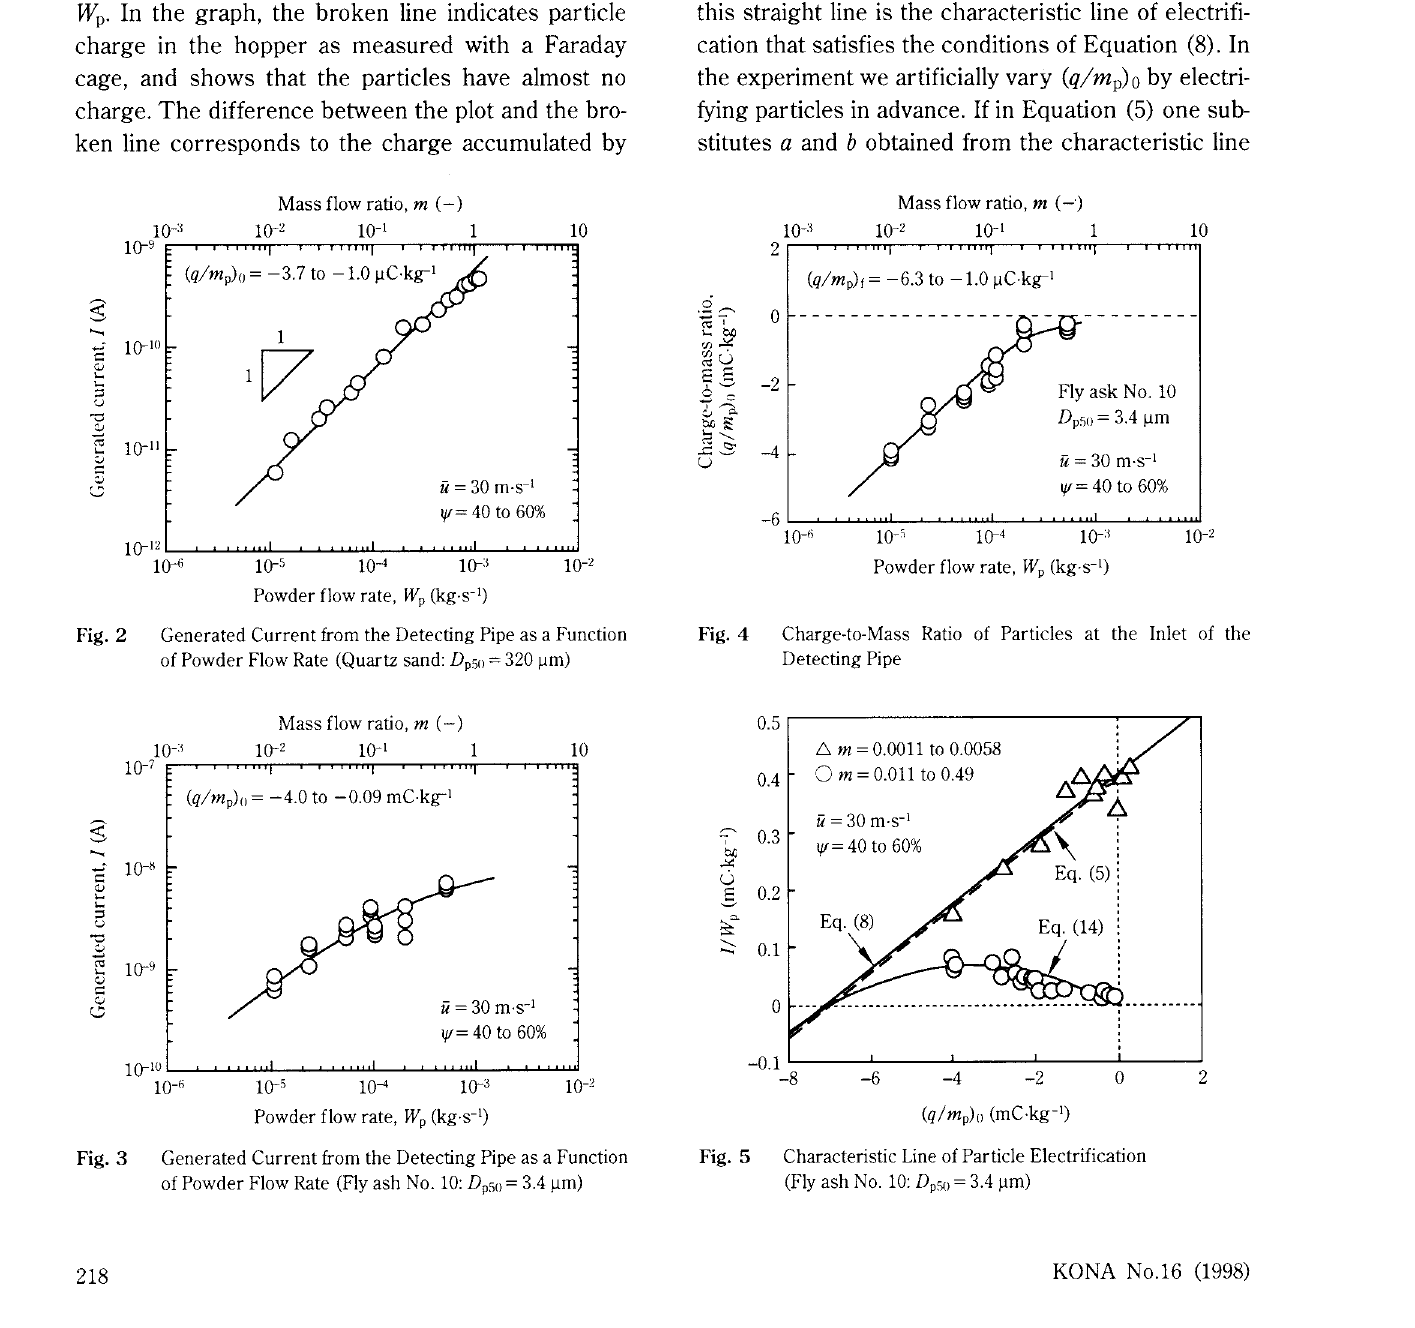
Characteristic Line of Particle Electrification (Fly ash No. 10: Dp 511 =